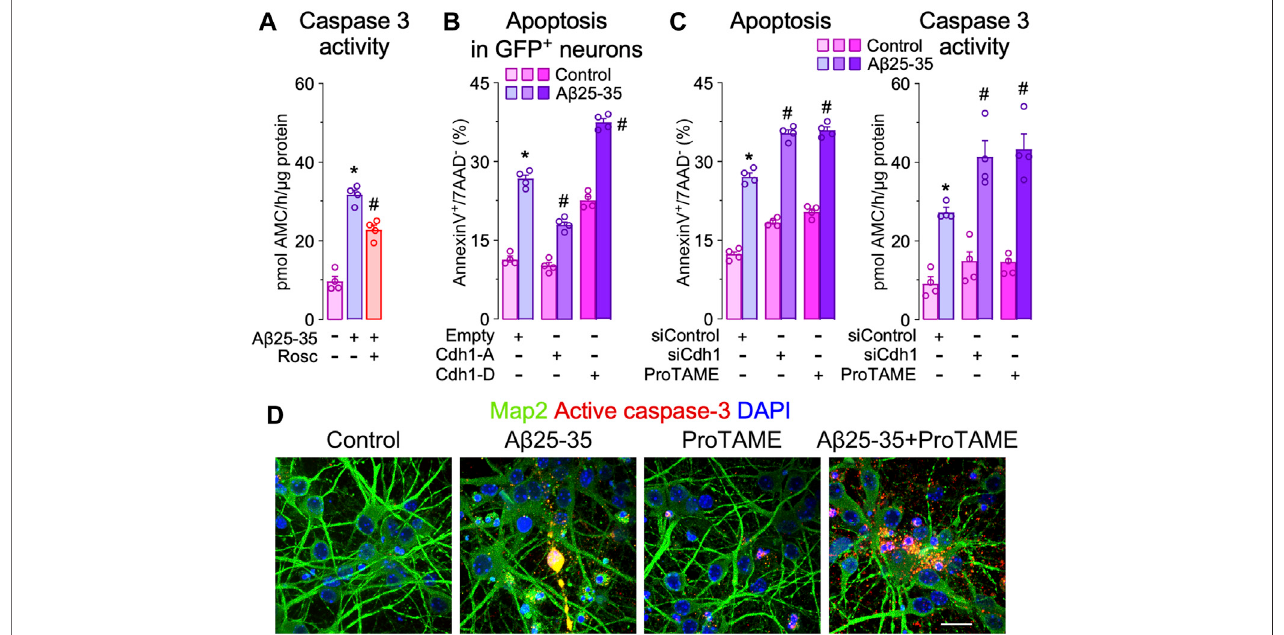
FIGURE 2 | Cdh1 phosphorylation mediates A β 25-35 neurotoxicity. Primary cortical neurons were incubated in culture medium in the absence (control) or the presence of oligomerized A β 25-35 (10 μ M). When indicated, medium was supplemented with roscovitine (10 μ M; Rosc) or ProTAME (10 µM). (A) Caspase-3 activity determinationinneuronsat24 hofincubationwithA β 25-35androscovitine( n =4neuronalcultures). (B) Neuronsonday6 invitro weretransfectedwithemptyvectoror vectors co-expressing GFP and either the phosphodefective (Cdh1-A) or the phosphomimetic (Cdh1-D) forms of Cdh1 and were subjected to Aß25-35 exposure for 24 h. Apoptosis was measured by fl ow cytometry in GFP + (transfected) neurons ( n = 4 neuronal cultures). (C) Neurons on day 6 in vitro were transfected with siRNA control (9 nM) or with siRNA against Cdh1 (siCdh1; 9 nM) for 2 days and then treated with A β 25-35 oligomerized and ProTAME. Neuronal apoptosis and caspase-3 activity were analyzed in neurons at 24 h of incubation with A β 25-35 ( n = 4 neuronal cultures). (D) Active caspase-3 and Map2 (neuronal marker) immunocytochemical analysis in neurons treated with A β 25-35 and ProTAME for 24 h. Scale bar = 20 µm. Data are mean ± SEM for the indicated number of neuronal cultures. * p < 0.05 versus control; # p < 0.05 versus A β